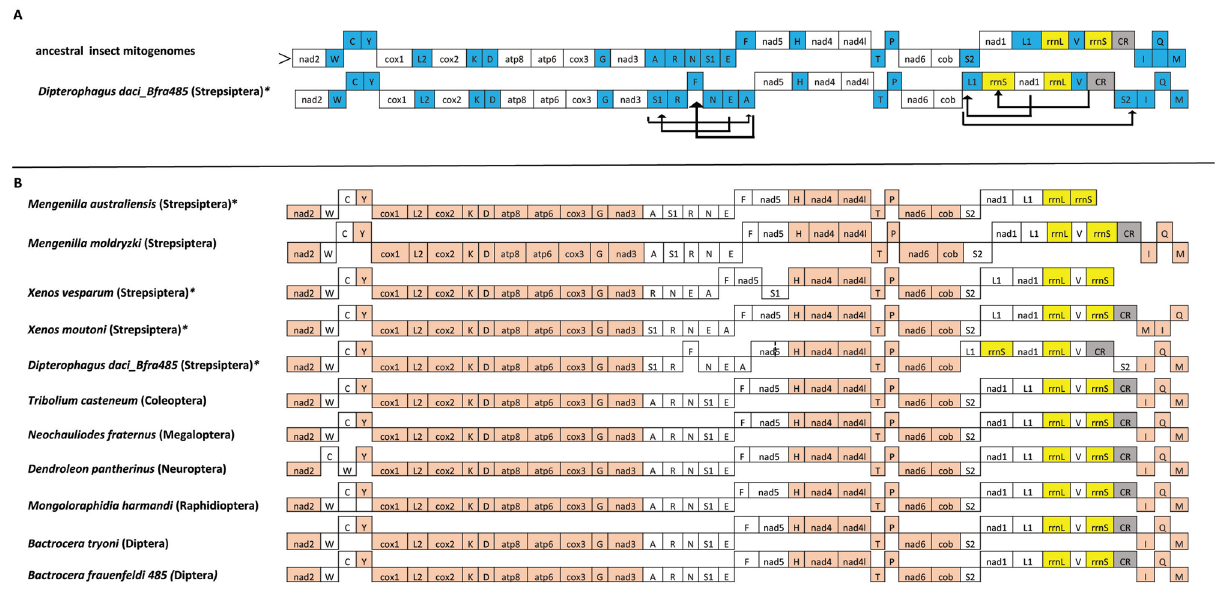
Figure 4. Organisation and rearrangement of the Dipterophagus daci mitogenome ( A ) compared to the ancestral holometabolan pattern; tRNA genes are blue, rRNA genes are yellow, protein coding genes are white and the control region is grey. The major (leading) strand is denoted by > and arrows denote gene translocations; ( B ) compared to ten other insect species (including four strepsipteran species and the host species Bactrocera frauenfeldi and Bactrocera tryoni ); conserved gene arrangement (salmon colour) and different gene arrangements (white) in D. daci and the other species; the control region is grey . Mitogenome representation is not drawn to scale; * indicates species for which only incomplete mitogenomes are available.